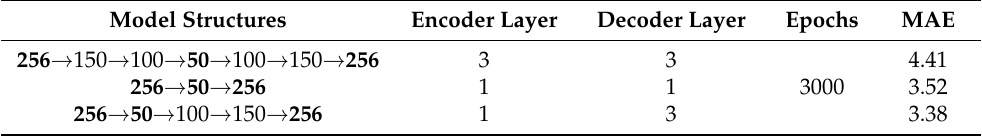
Table 3. Comparisons of error reconstruction rates in models with different